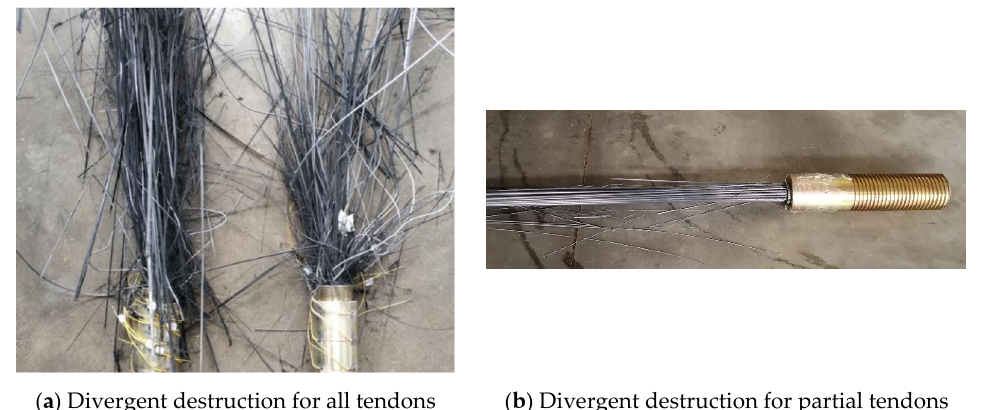
Figure 9. Static load tests result.